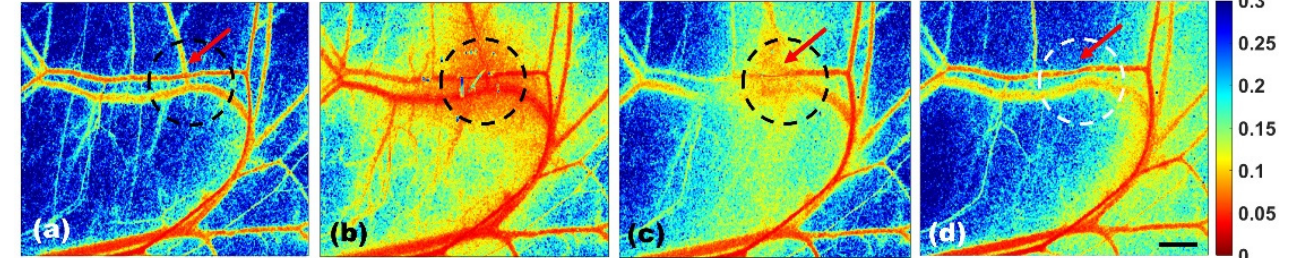
Figure 6. Real-time monitoring of blood flow and thrombosis-formation monitoring by using the sLSCI algorithm (scale bar = 100 µm). The red arrow indicates the target vessel. ( a ) Before irradiation, ( b ) during irradiation, ( c ) thrombosis formation, ( d ) after irradiation.